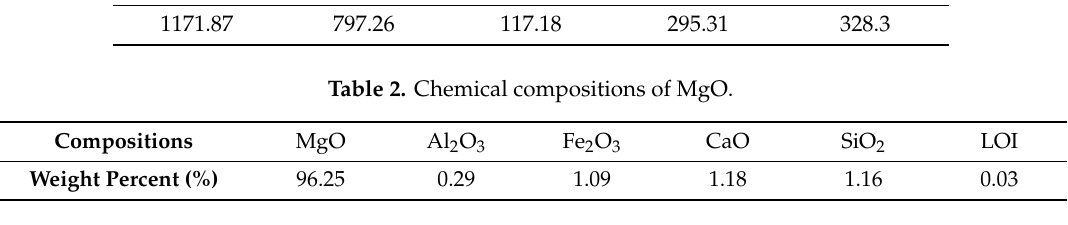
Table 3. Chemical compositions of fly ash